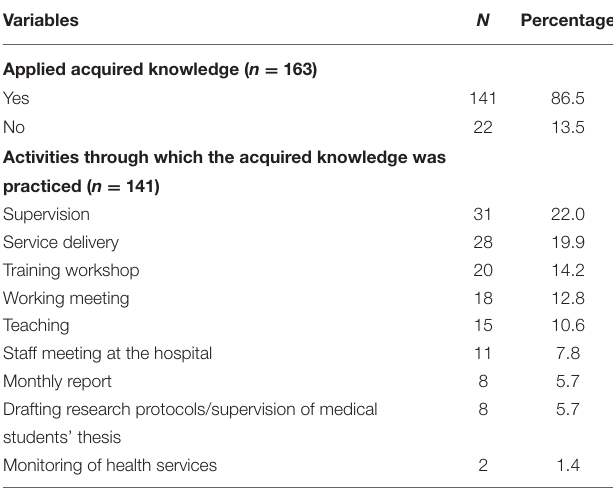
TABLE 5 | Application of new knowledge and